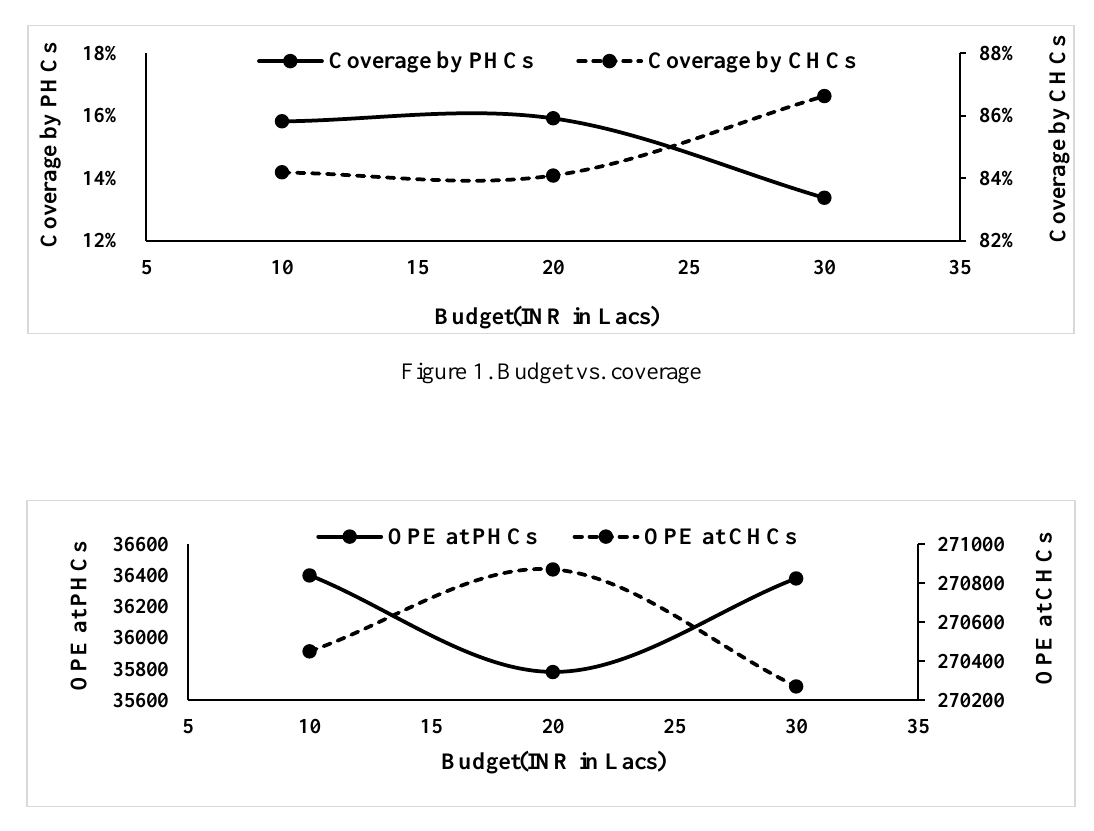
Figure 2. Budget vs. out-of-pocket expense